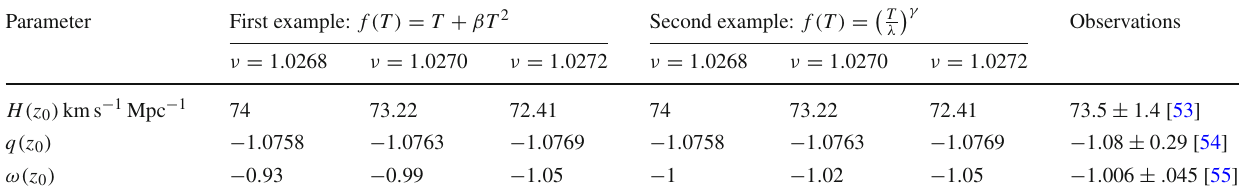
(cid:8) (cid:9) T λ